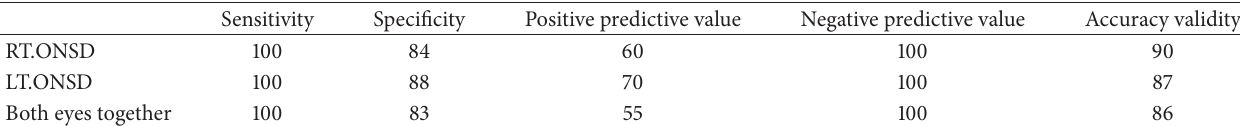
Table 2: Sensitivity, specificity, positive predictive value, negative predictive value, and accuracy validity of optic sonography in diagnosis of PPE.